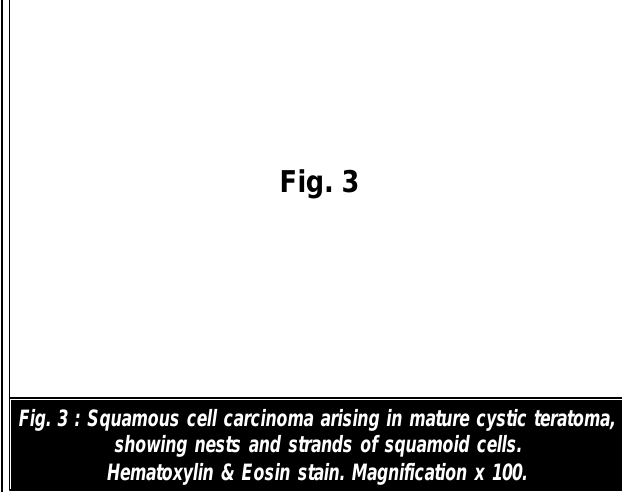
Fig. 3 : Squamous cell carcinoma arising in mature cystic teratoma, showing nests and strands of squamoid cells. Hematoxylin & Eosin stain. Magnification x 100.